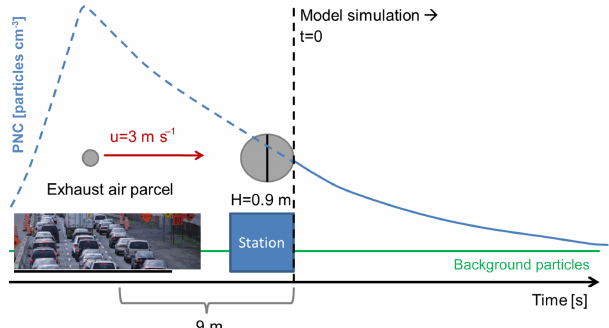
Figure 1. Idealized scenario for model simulations with MAFOR to study aerosol processes between roadside and neighborhood scale. Model simulations start at the point where the exhaust parcel (plume height typically 0.9m) has approached the roadside traffic station. The simulations are initialized with PN concentration and size dis- tribution measured at roadside. Particle concentrations in the ex- haust air are diluted by background air with constant PN concentra-